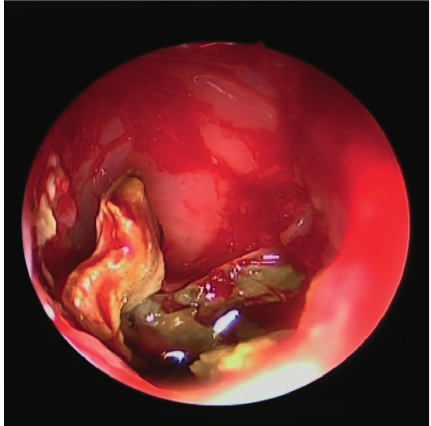
Figure 3: 30-degree endoscopic view showing right maxillary fungal